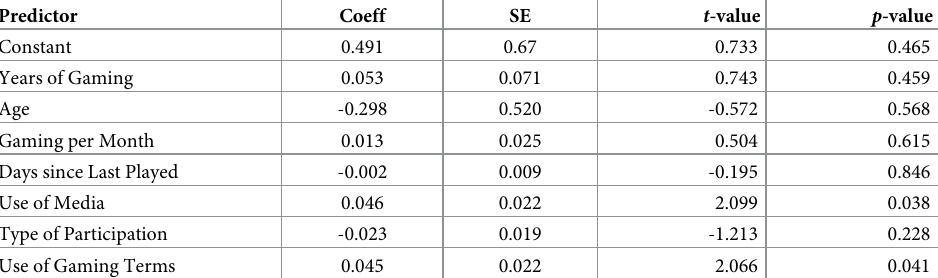
Table 9. Experiment 2: Multiple regression of participant response predicted by gaming experiences, use of media, type of participation, and use of gaming